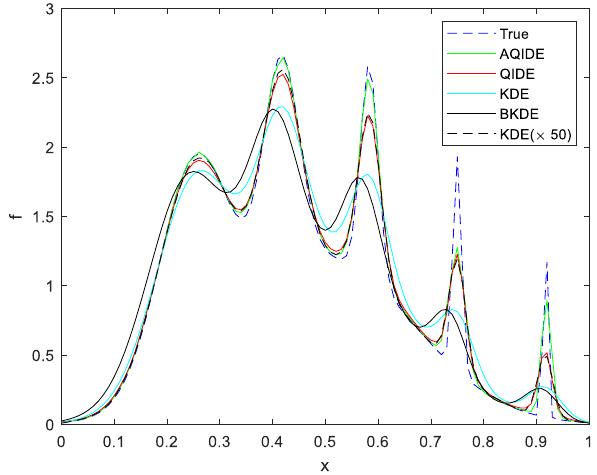
Figure 3. Sketches of asymmetrical claw